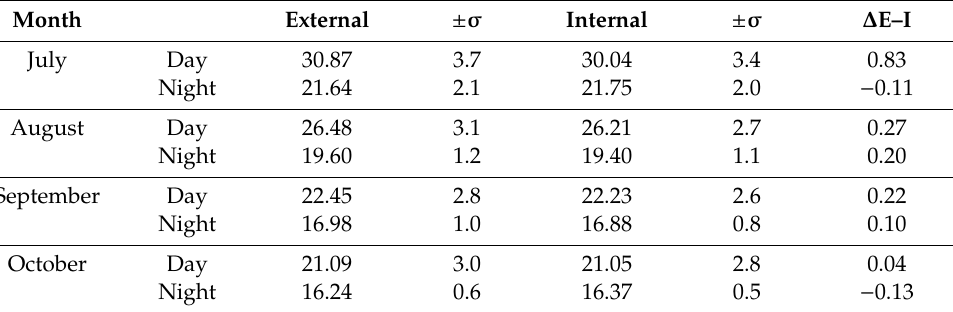
Table 2. Fruit quality parameters for bagged (B) and not bagged (NB) grapes: bunch mass (g), berry number, berry mass (g), rachis length (cm), compactness index, shape (longitudinal and transversal diameter, DL/DT), percentage of aborted seeds, SSC (soluble solid content, °Brix), titratable acidity (g/L), and soluble solid content/titratable acidity ratio (SSC/TA). Autumn Royal Regal Seedless Italia Parameter u.m. B NB Sig. B NB Sig. B NB Sig. Bunch mass g 965.40 661.24 Berry number 124.49 93.60 111.40 ** Berry mass g 8.09